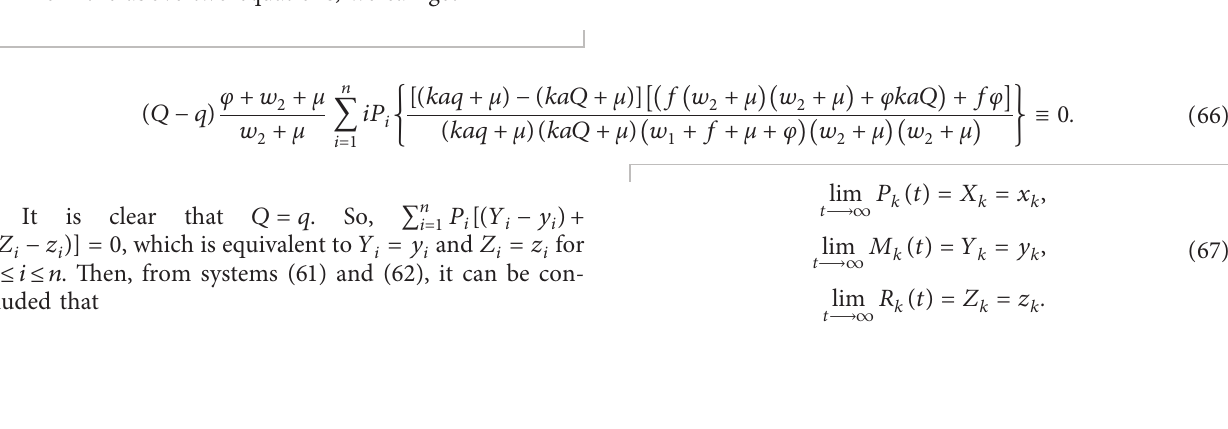
Figure 3: The time series and orbits of four states with R